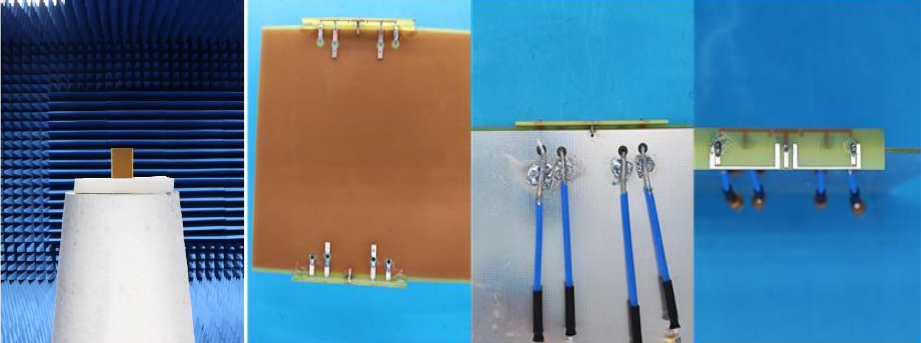
Figure 10. The fabricated prototype of the proposed antenna.